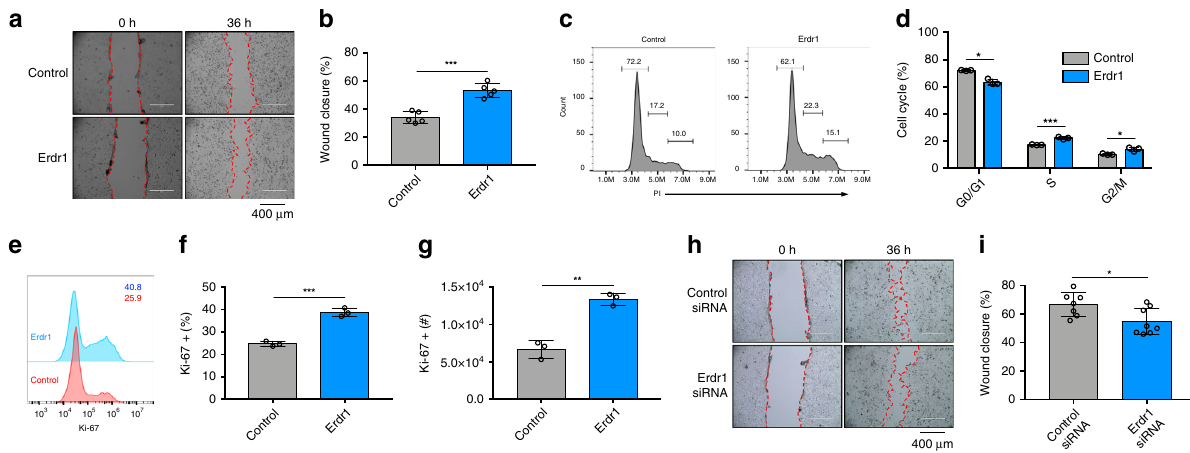
Fig. 6 Erdr1 accelerates wound closure in mouse and human intestinal epithelial cells. Scratch-wound assay using Mode-K mouse intestinal epithelial cells cultured ±Erdr1 (1 μ g/mL) for 36 h ( a picture; b % wound closure). n = 5; representative of three experiments. c – d Cell cycle analysis of Mode-K cells cultured ±Erdr1. n = 3; representative of three experiments ( c histogram; d % cell cycle). e – g Ki-67 staining of Mode-K cells stimulated ±Erdr1. n = 3; representative of three experiments. h – i Wound closure of Mode-K cells treated with Erdr1 siRNA or control siRNA ( k picture; l % wound closure). n = 7 (control siRNA), n = 8 (Erdr1 siRNA); representative of two experiments. All data are presented as mean ± SD; * P < 0.05, ** P < 0.01, *** P < 0.001 by unpaired, two-tailed t